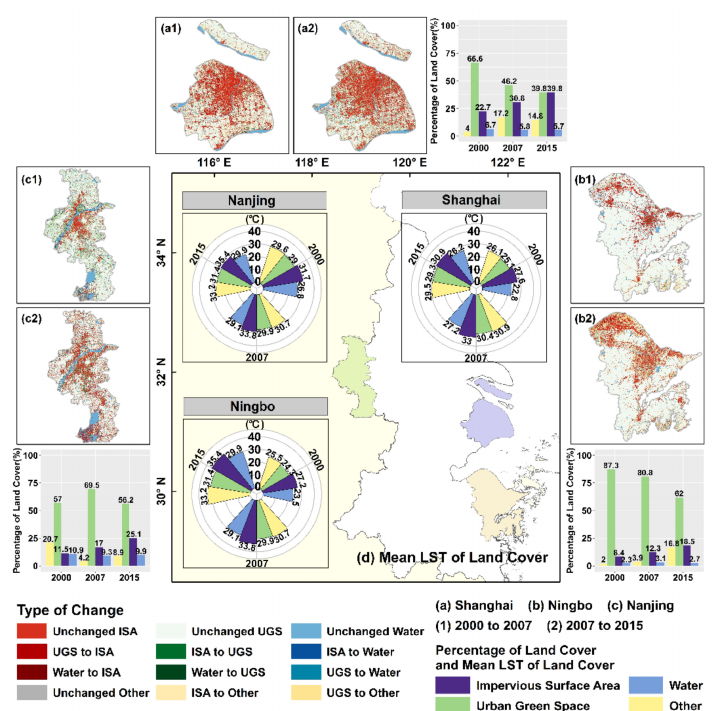
Figure 5. Changes of LSC within Shanghai, Ningbo and Nanjing from 2000 to 2015, percentage of different LSC and the LST related to each